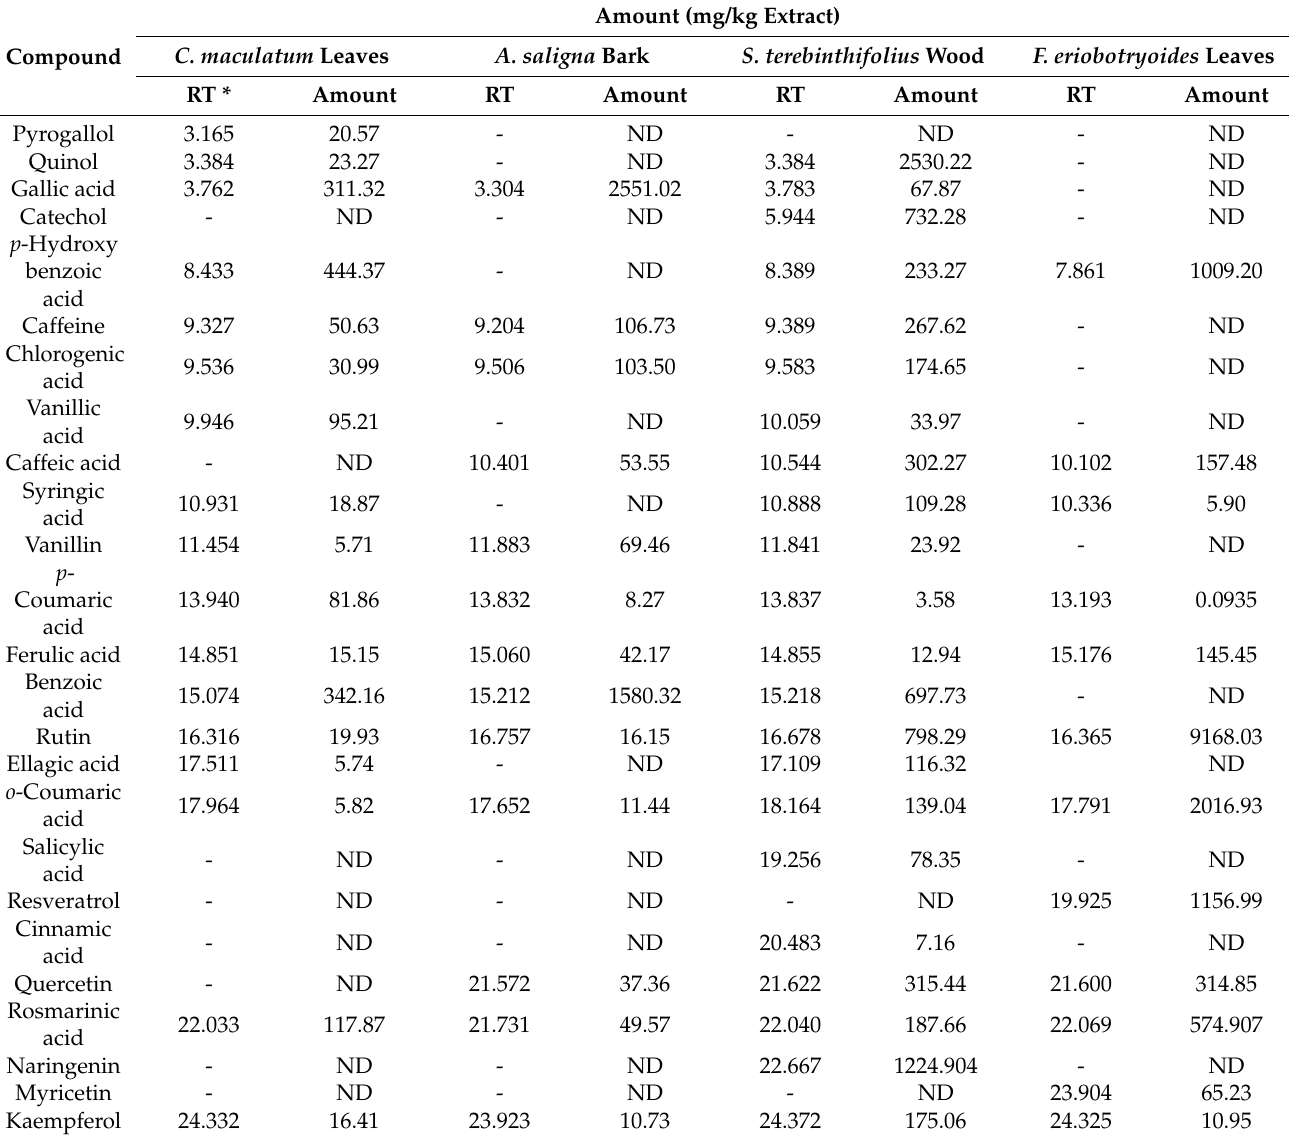
Table 1. Phytochemical compounds of extracts by HPLC